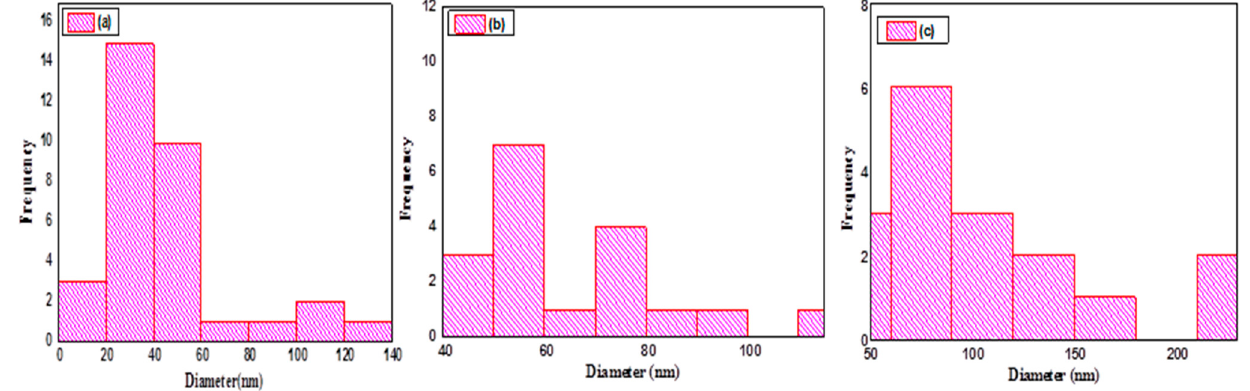
Figure 7. Particle size distribution for Cu x S y nanoparticles prepared in ( a ) OLA, ( b ) HDA, and ( c ) DDA at 230 °C using complex 2.